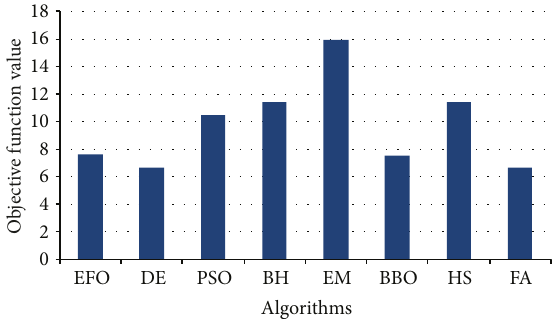
Figure 7: Best results obtained, for the IEEE 8-bus model, by different techniques are compared with the firefly algorithm [3].